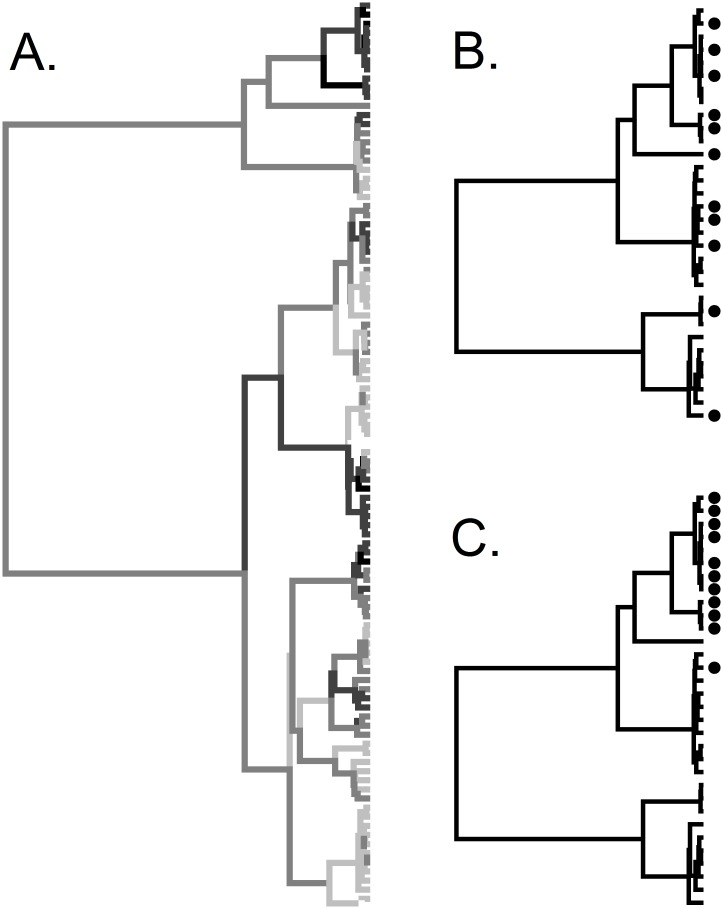
A hypothetical phylogeny of 100 plant species.(A) Darkness of branches is proportional to species’ vulnerability and shows strong phylogenetic signal (clustering), with species that are more (or less) at risk being more closely related than expected by chance. (B) A subtree showing the 32 most vulnerable species from the full tree, of which 11 are found in ex situ collections (black circles). If these 11 collected species were compared to the full tree, they would be identified as clustered. However, they are randomly distributed in relation to the subset of vulnerable species. (C) Same subtree as (B) but with a different distribution of ex situ species. Here the collected species are not only clustered with respect to the full tree but are also a phylogenetically biased subset of vulnerable species.